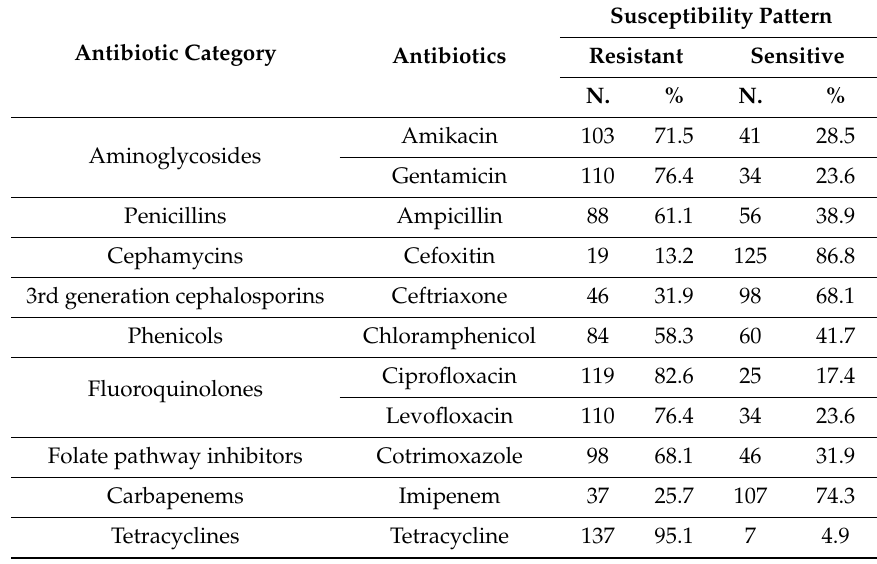
Table 2. Antimicrobial susceptibility pattern of E. coli isolates from colibacillosis-related dead poultry (n = 144).